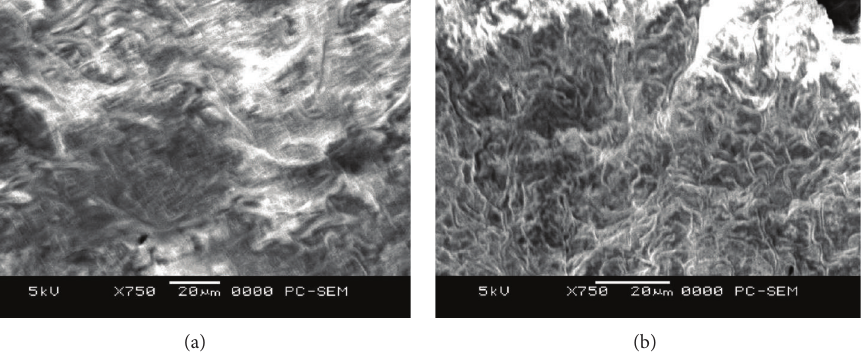
Figure 2: SEM of (a) unloaded ALP and (b) Hg(II) loaded ALP.